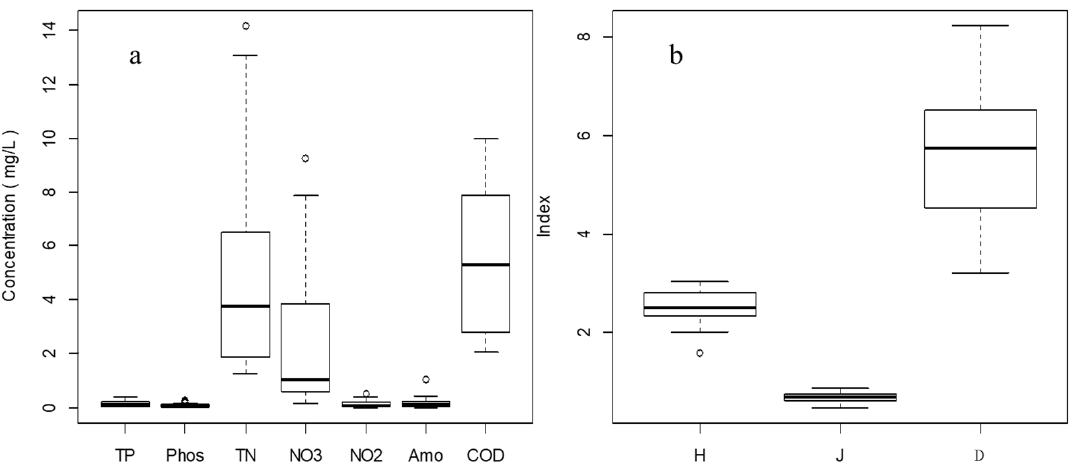
Figure 2. The water chemistry ( a ) and phytoplankton community structure parameters ( b ) for the Haihe River in Tianjin, China. H, J, and D represent the Shannon–Wiener index, Pielou evenness index, and Margalef richness index values, respectively, for the Haihe River in Tianjin, China.